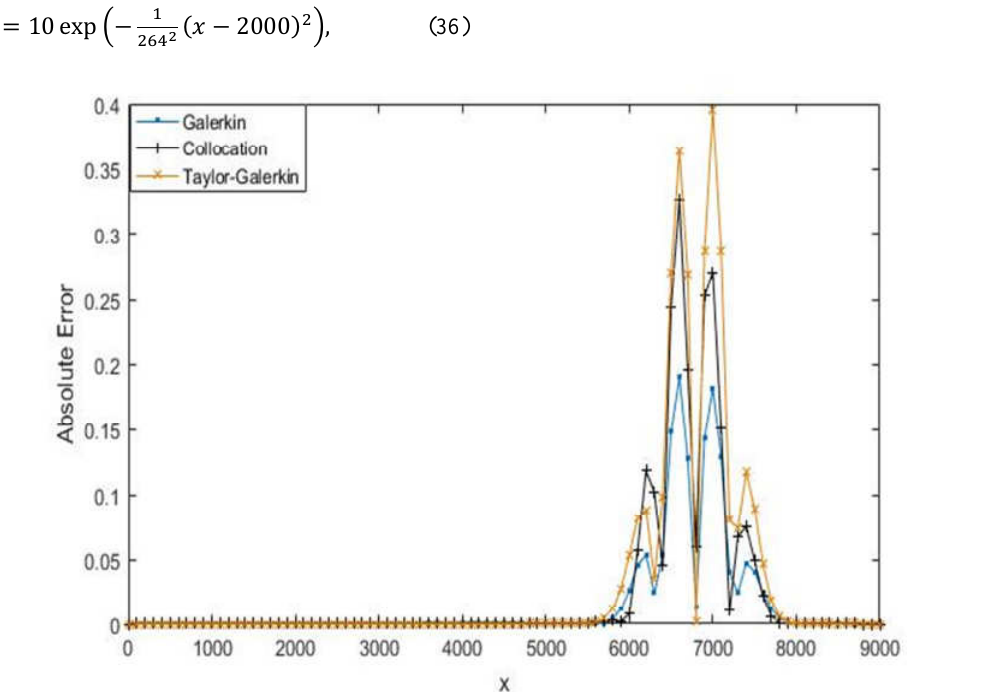
Figure 2. Comparison of the absolute error norms of various schemes with (cid:1) (cid:2) 0.5 , (cid:10) (cid:2) 100 (cid:12) , (cid:13)(cid:14) (cid:2) 50 (cid:15) and (cid:14) (cid:2) 9600 (cid:15)